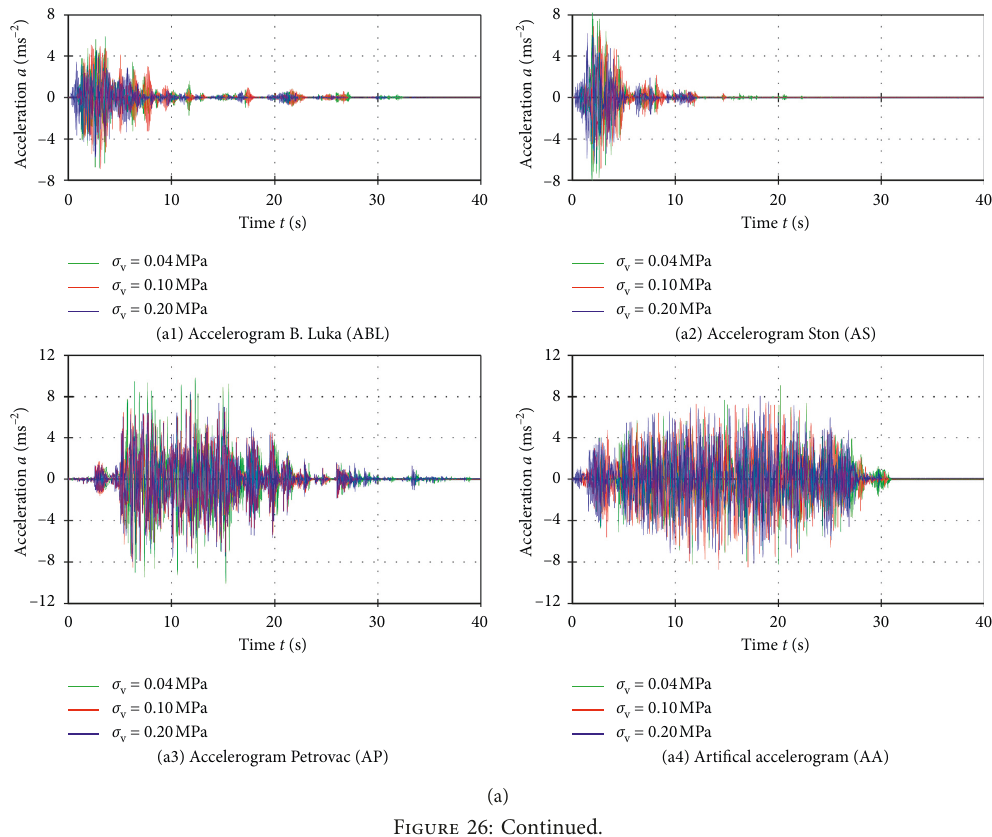
� 0.2 g. (b) PGA � 2 . (a) PGA